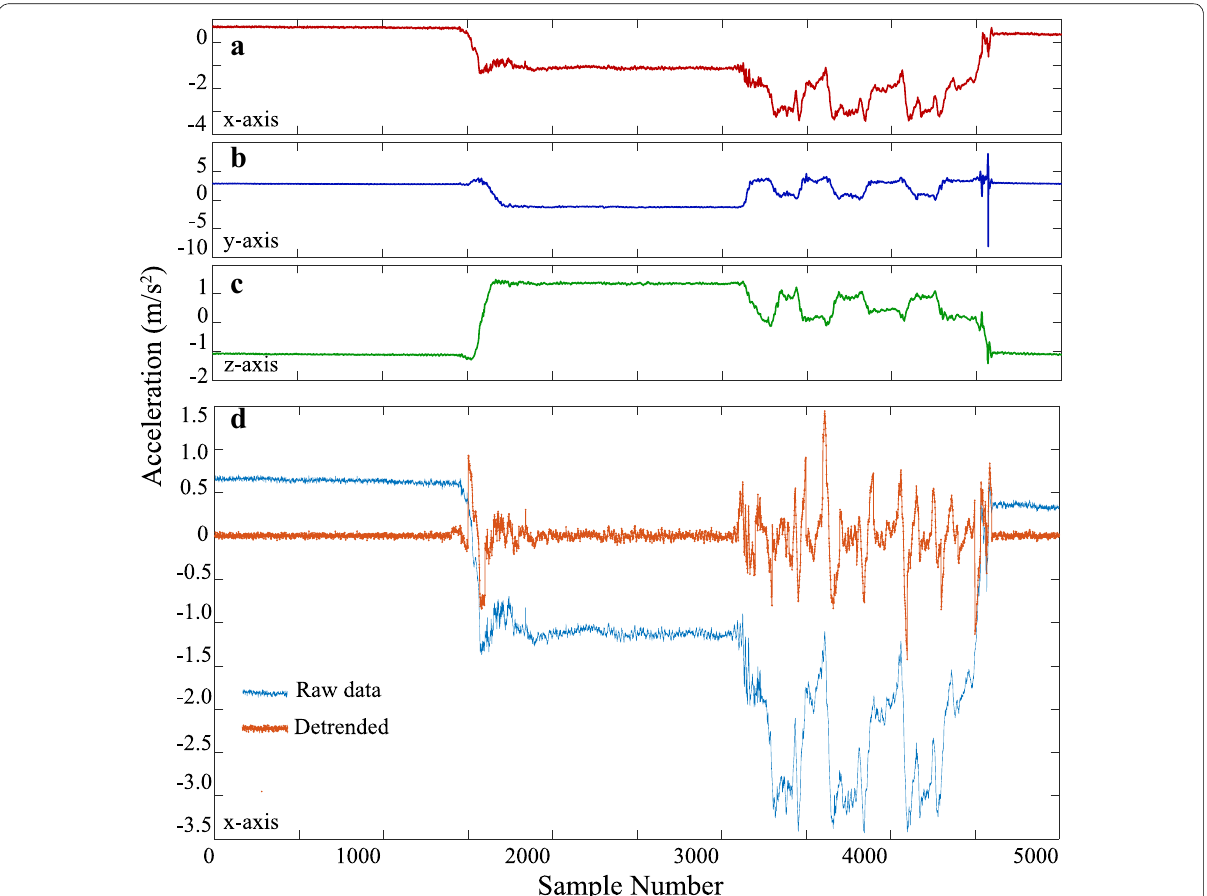
Fig. 2 Raw data and detrended data: a – c x,y and z axis acceleration data with smartphones orientation change during experiment. d Detrended x-axis data to remove the effect of